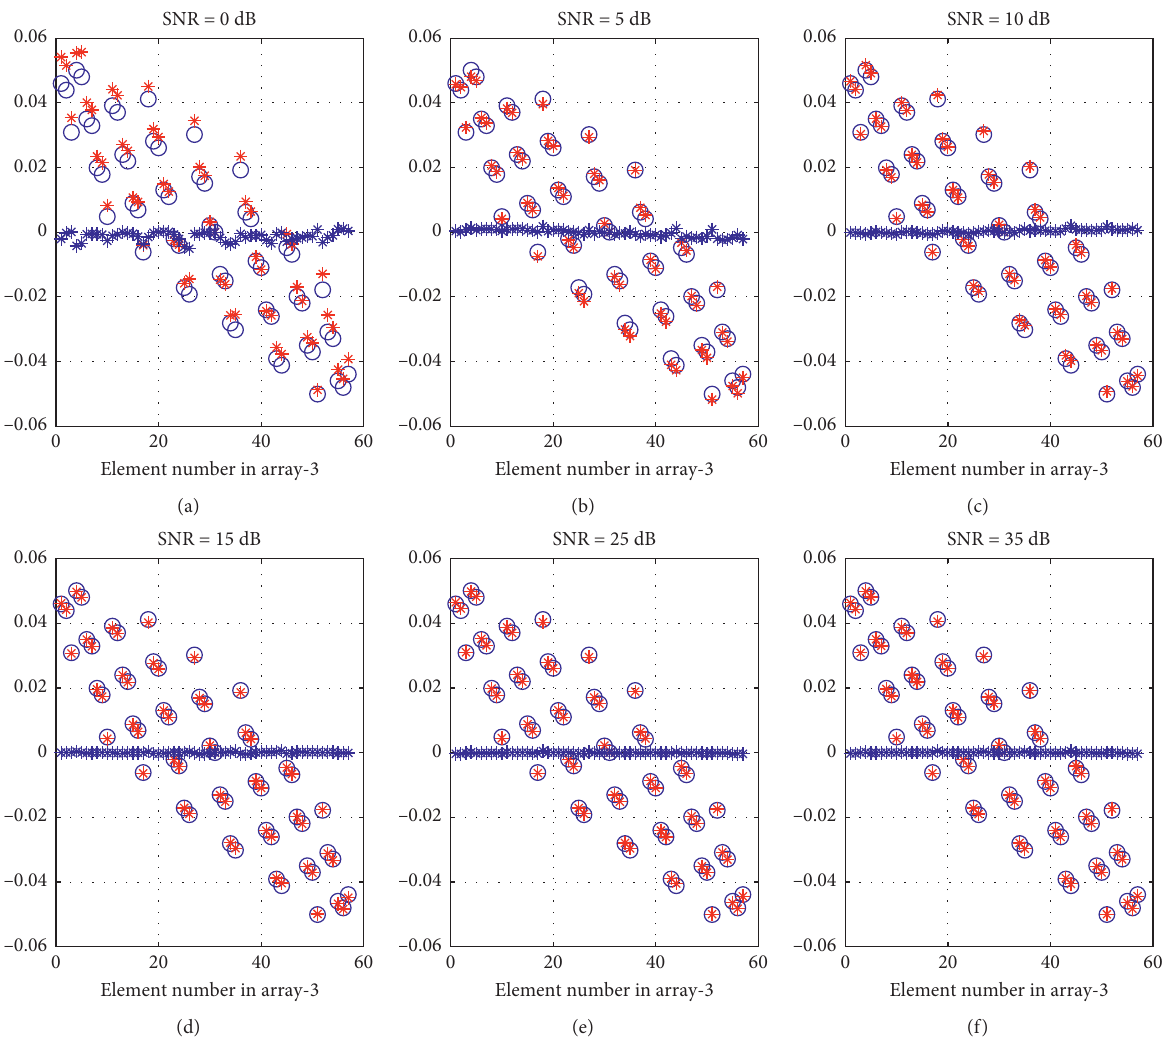
Figure 23: The comparison between the values of the first-term (blue oooo) and the imaginary part of the second-term (red ∗∗∗∗ ) of (D.2) with different SNRs, when the frequency is at 10GHz, the incident direction is from (143.75 ° 84.66 ° ) to Array-3, the waveform is WF-1 and the number of snapshots is 512. Blue plus signs are the real part of the second term in (D.2). (a) SNR � 0 dB; (b) SNR � 5dB; (c) SNR � 10dB;